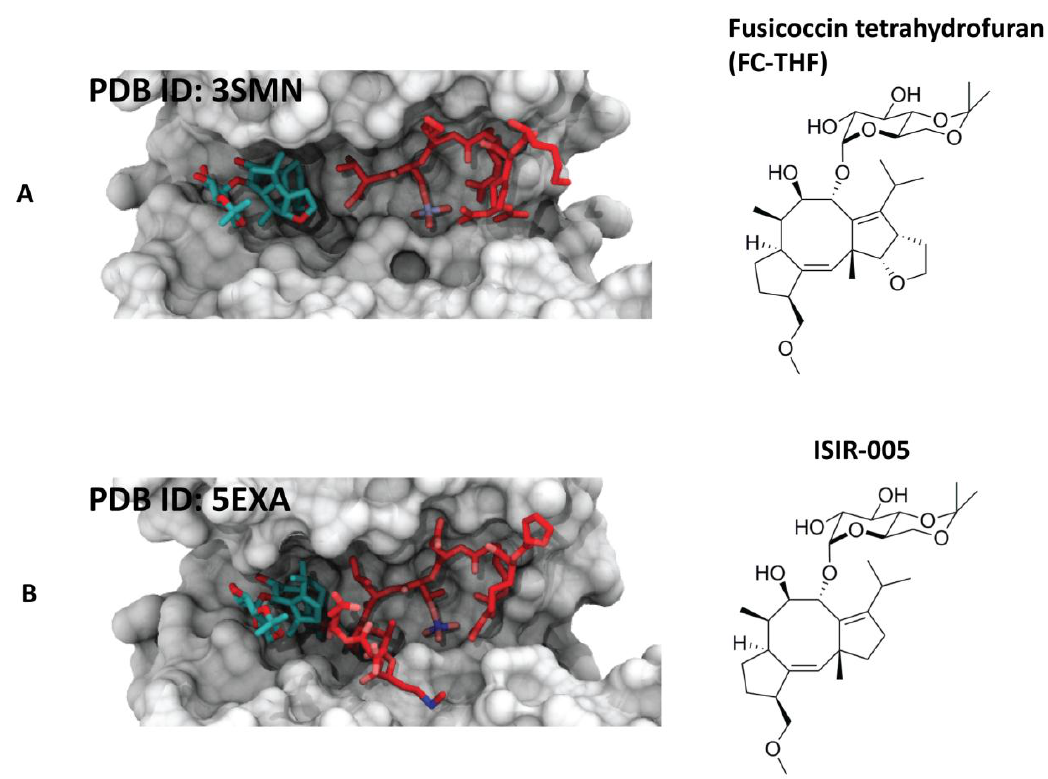
Figure 5. Examples of the different semisynthetic 14-3-3 PPI stabilizers. (A) Left side: crystal structure of 14-3-3 𝛔 (white surface) in complex with task-3 peptide (red sticks) and stabilizer Fusicoccin A-THF (cyan sticks) [35]; right side: chemical structure of Fusicoccin A-THF. (B) Left side: crystal structure of 14-3-3ζ (white surface) in complex with Gab2 peptide (red sticks) and ISIR-005 (cyan sticks) [11]; right side: chemical structure of ISIR-005.